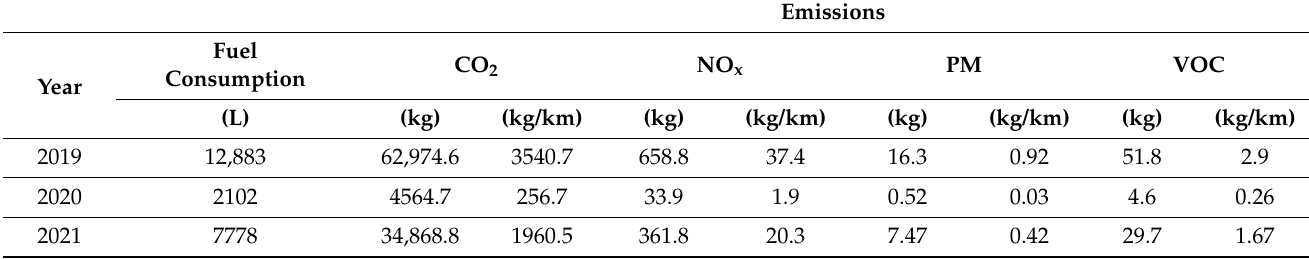
Table 3. Resulting values of the estimated total fuel consumption and emissions produced for the whole